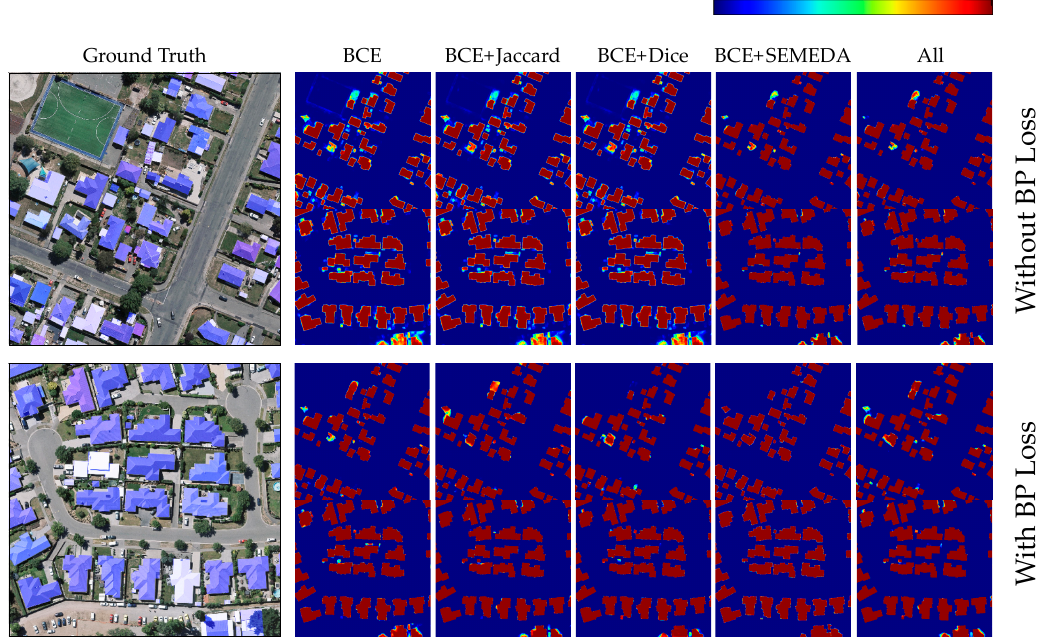
Figure 8. The images and corresponding masks are listed in the first column. Starting with the second column, the top parts of the building probability maps are predicted from the pipeline networks trained with BCE loss, BCE+Jaccard loss, BCE+Dice loss, BCE+SEMEDA loss and with all 4 losses together. With the same order, the building probability maps predicted from the pipeline networks refined with BP loss are located on the bottom part.